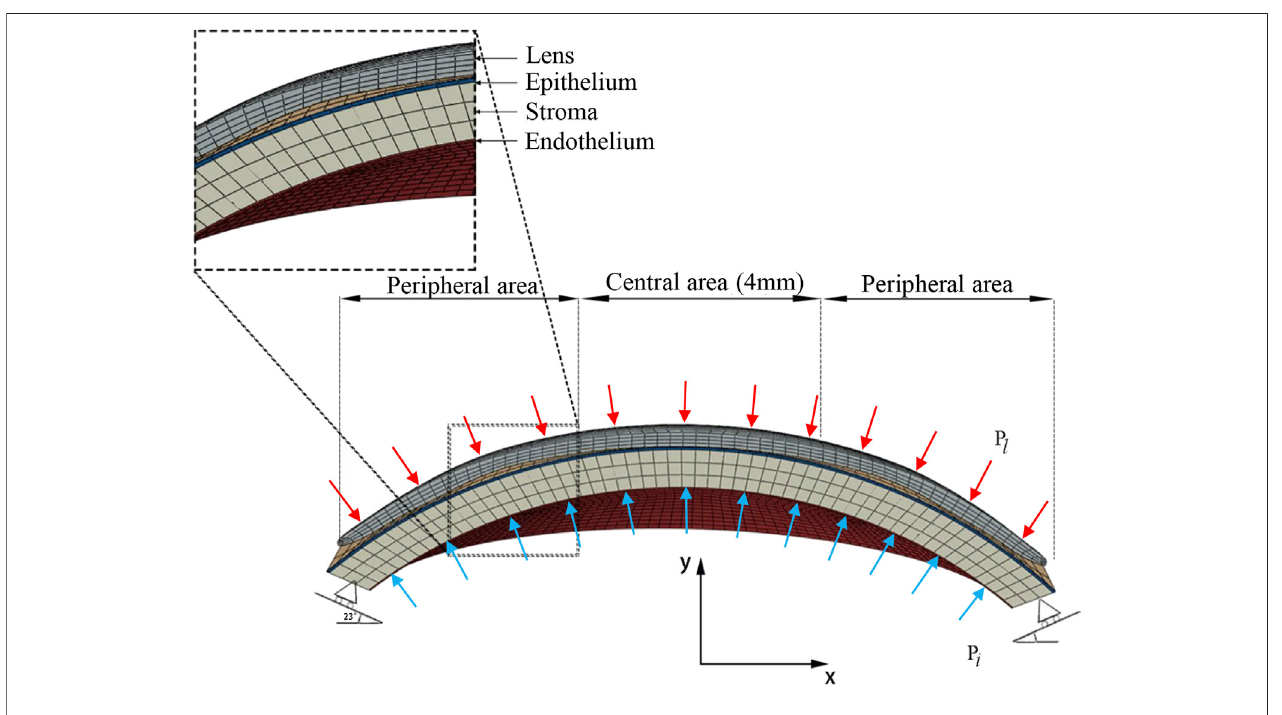
FIGURE 2 | FEA models of ortho-k lens and the